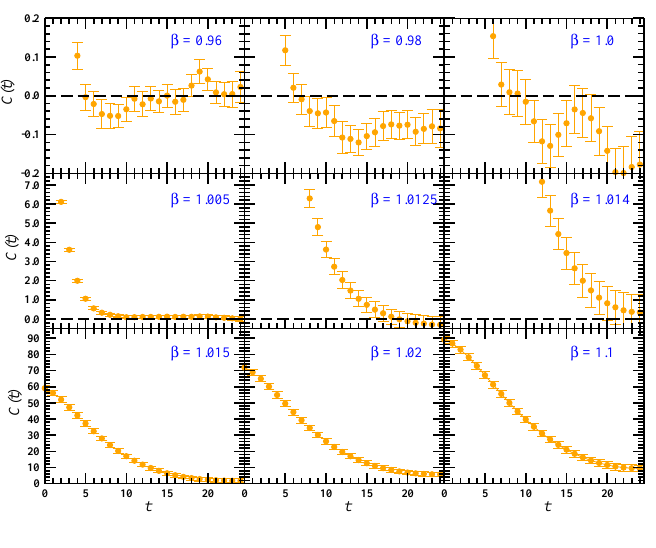
Figure 6. The photon Schwinger function near the transition from the confined to the deconfined